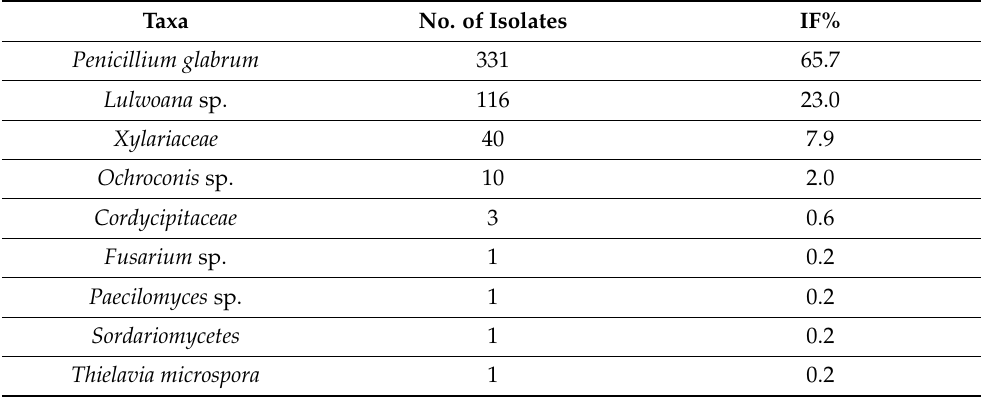
Table 2. Composition of the fungal population (504 colonies) isolated from the different P. oceanica organs in the three study sites.